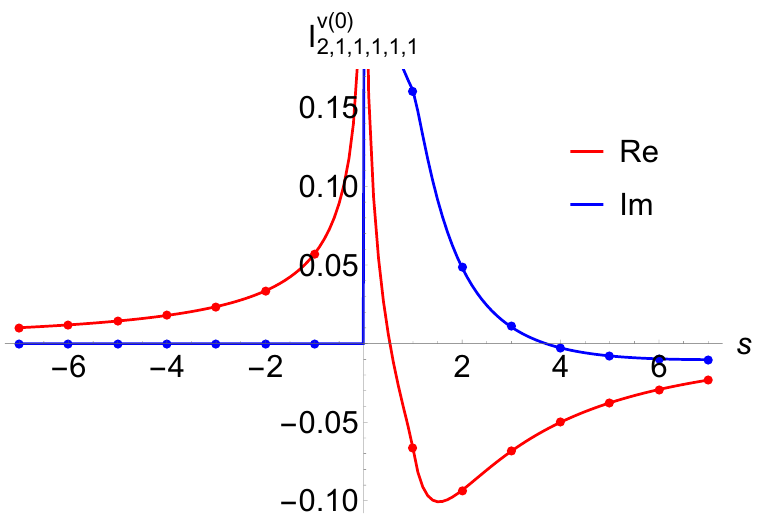
. The solid points represent values computed 2 , 1 , 1 , 1 , 1 , 1